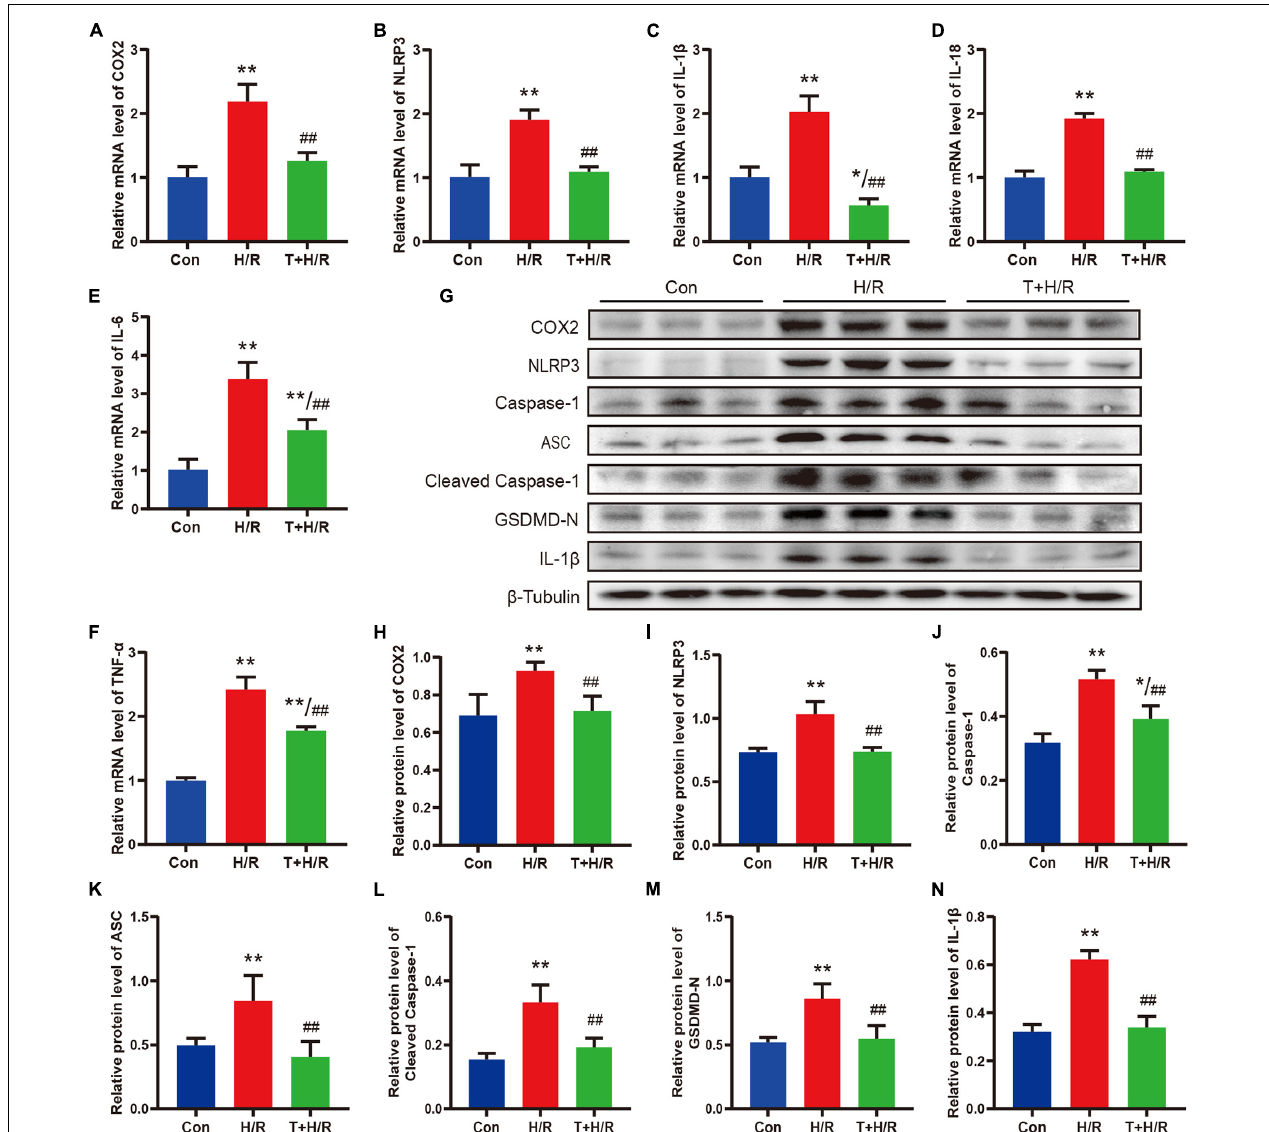
FIGURE 7 | Iguratimod ameliorated pyroptosis and the expression of pro-inflammatory cytokines of CFs subjected to H/R through inhibiting the COX2/NLRP3 signaling pathway. (A–F) Relative mRNA expression levels of COX2, NLRP3, IL-1 β , IL-18, IL-6, and TNF- α among Con, H/R and T + H/R group. n = 4. (G) Representative Western blotting luminogram of COX2, NLRP3, caspase-1, ASC, cleaved caspase-1, GSDMD-N, and IL-1 β of the three groups. (H–N) Protein semiquantification standardized by β -Tubulin. n = 5. Data are expressed as mean ± SD; * p < 0.05, ** p < 0.01 versus Con group; ## p < 0.01 versus H/R group. CFs, cardiac fibroblasts; H/R,